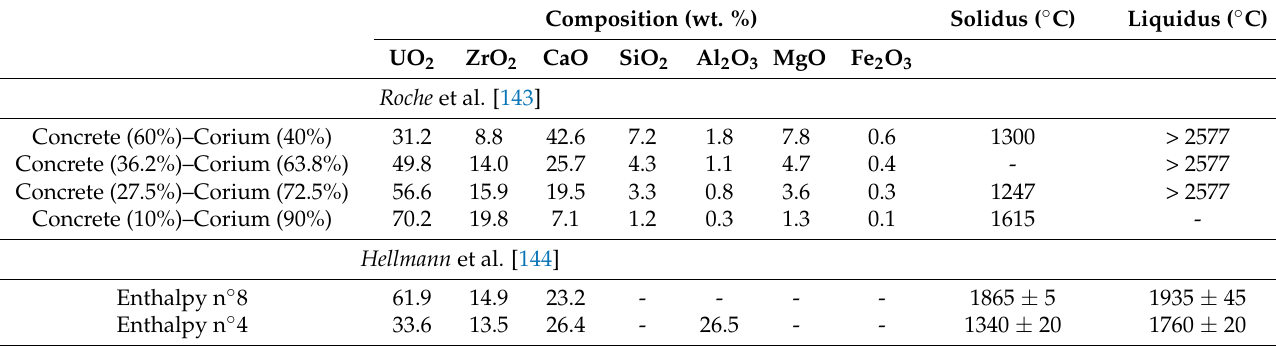
Table 5. Corium–limestone concrete compositions and measured solidus and liquidus temperatures [143,144]. Composition (wt. %)